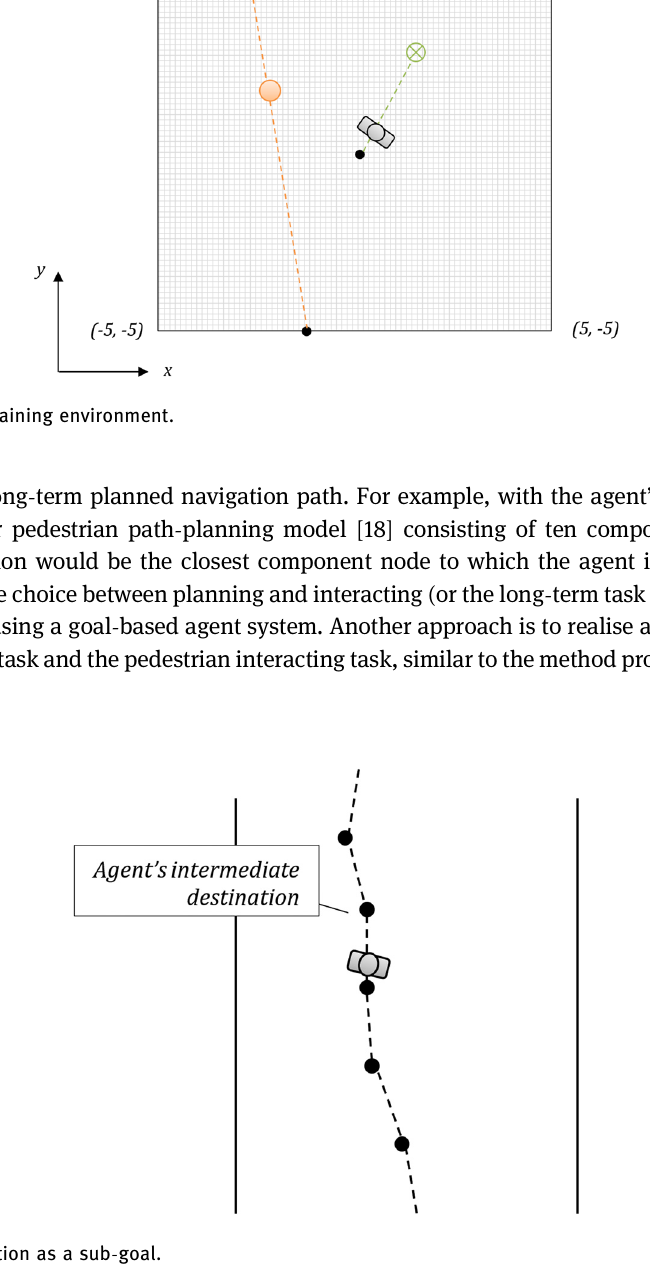
Figure 3: Agent ’ s destination as a sub -